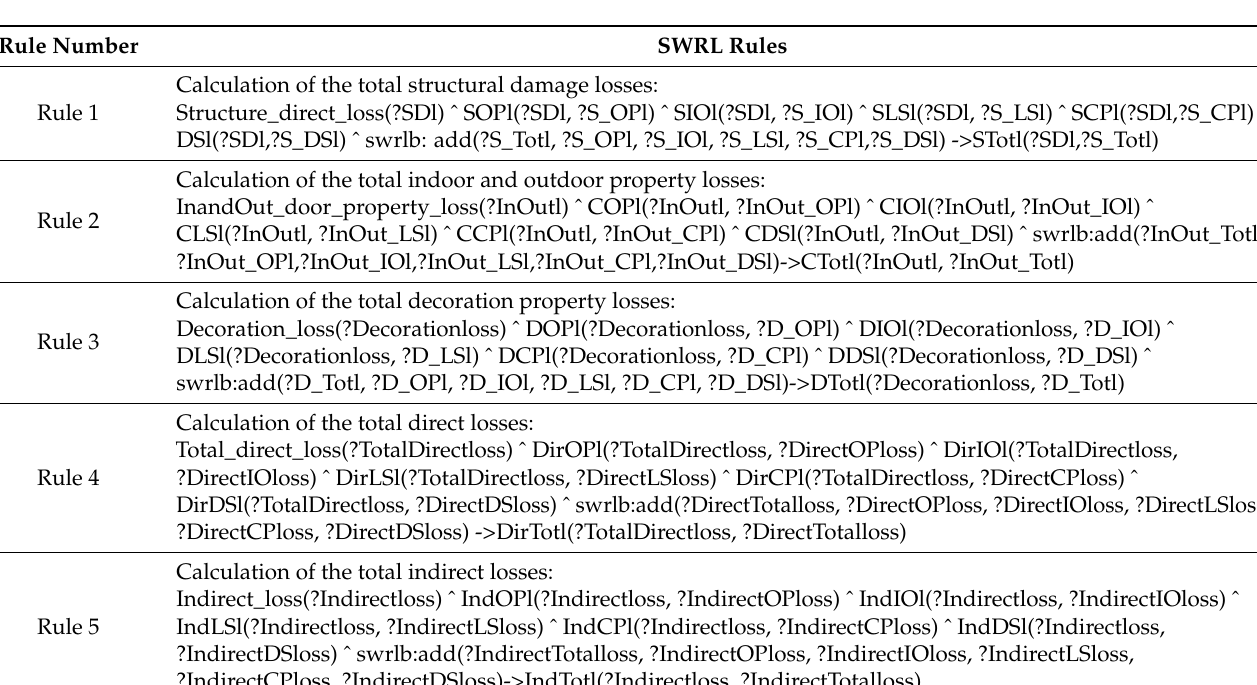
Table 11. Main SWRL rules for the seismic risk